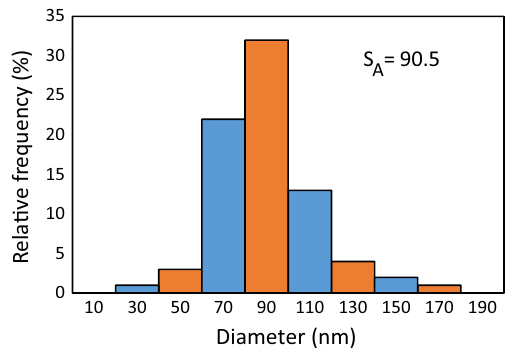
Figure 6. The size distribution of particles.